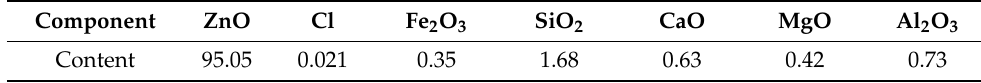
Table 3. Chemical analyses of zinc ash after dechlorination, wt.%.